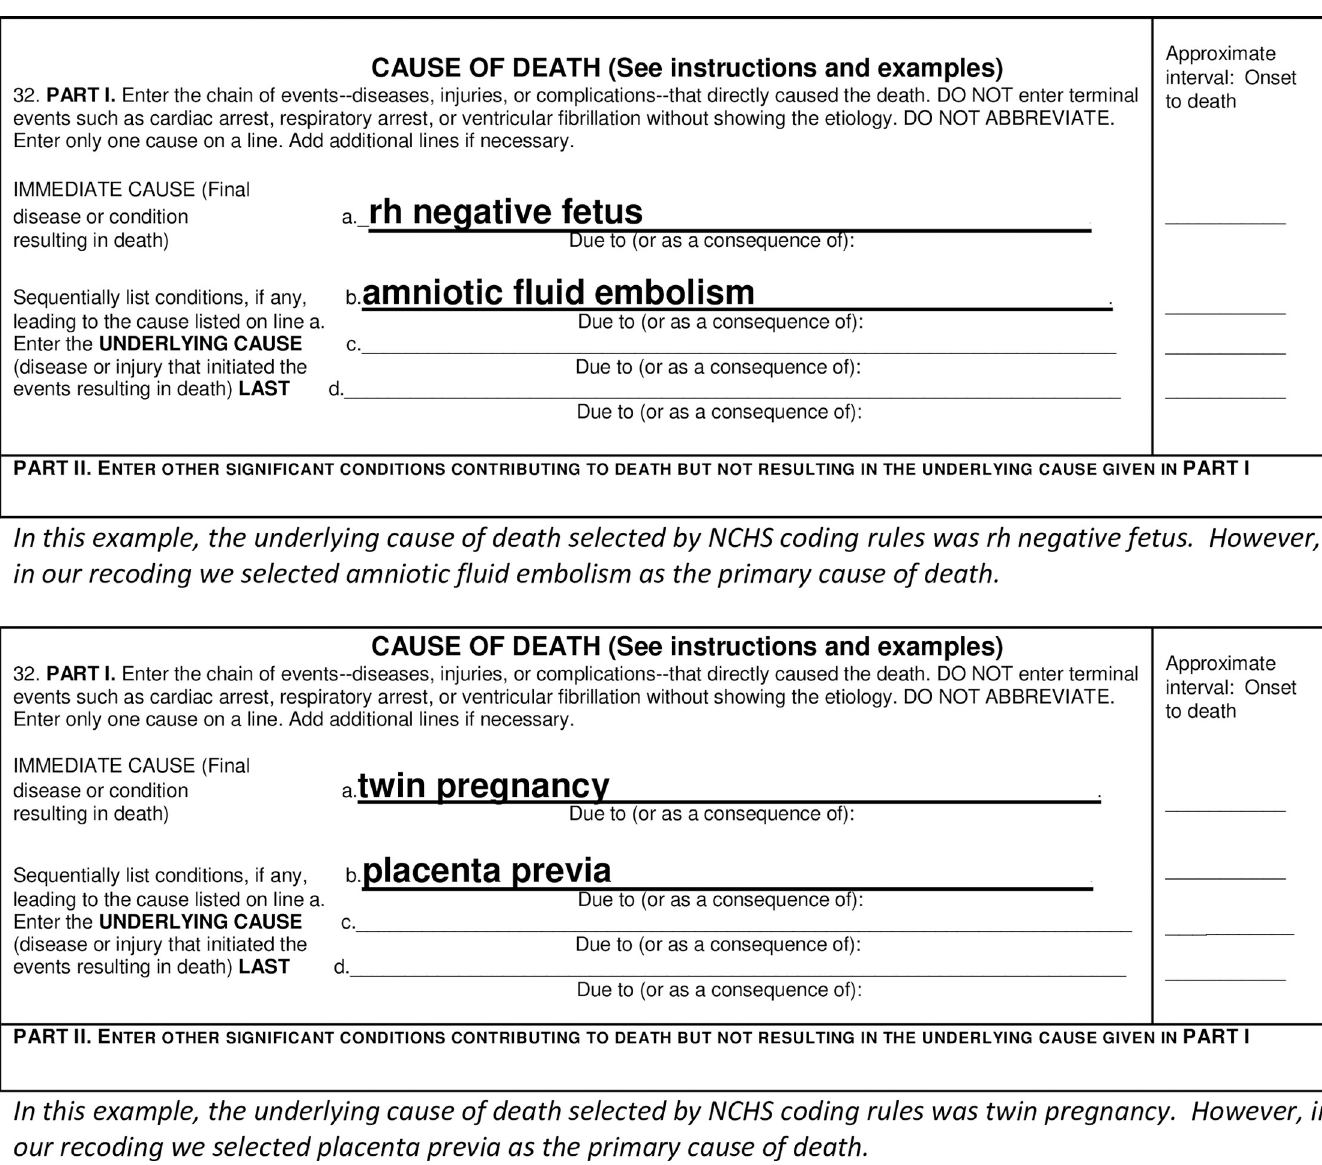
Fig 1. Examples of improper cause-of-death